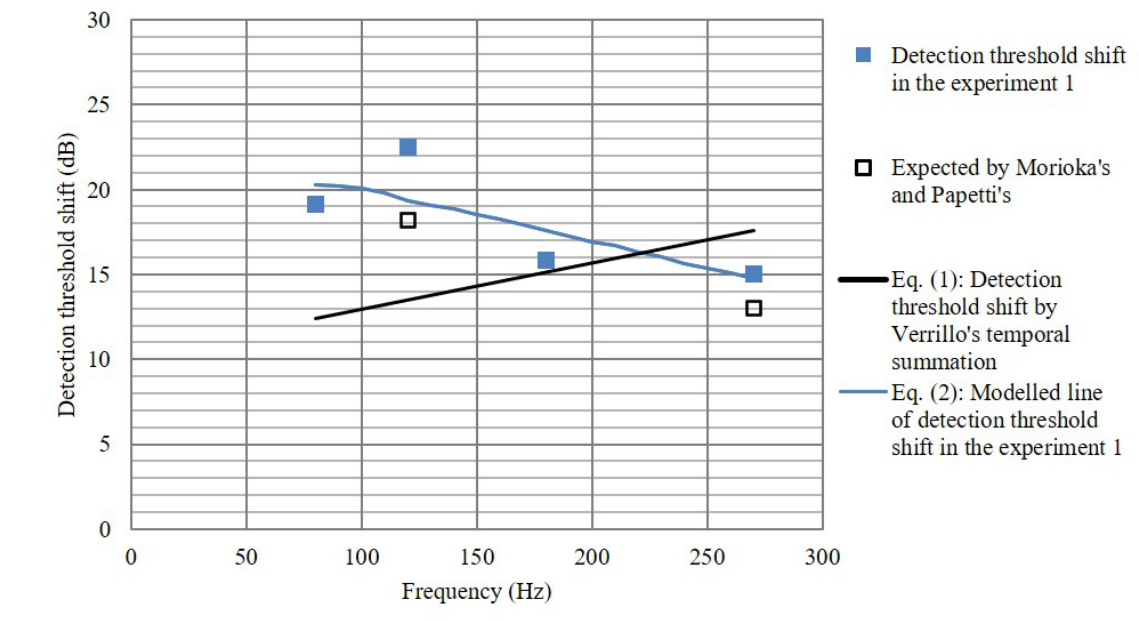
Figure 6. A shift in the detection threshold according to the frequency of the haptic stimulation (Solid line in black: Verrillo’s experimental results; Solid line in blue: Modelled line of detection threshold shift in experiment 1; Closed symbols: Detection threshold shift in experiment 1; Open symbols: Expected shift by contact pressure in the